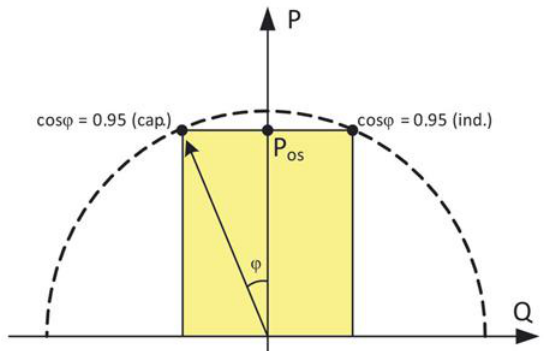
Figure 10. Extended reactive power capability of wind farms using STATCOM (yellow area) [40].